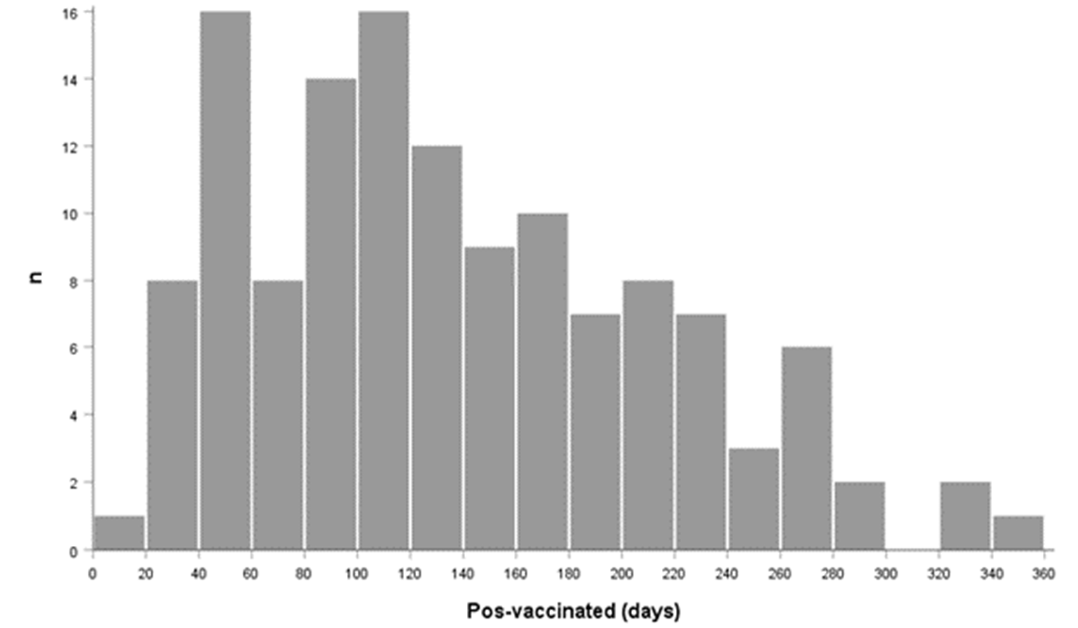
Figure 1. Frequency of the days elapsed between the last vaccine dose and sampling.